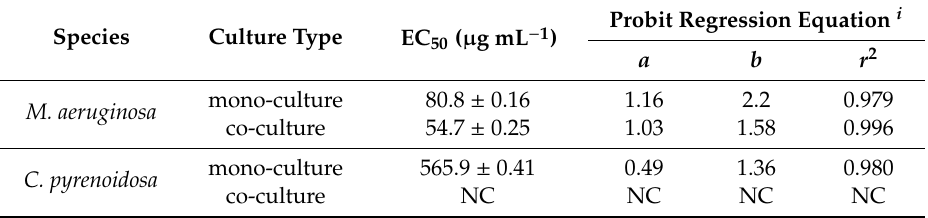
Table 2. EC 50 of phenol for M. aeruginosa and C. pyrenoidosa in mono- and